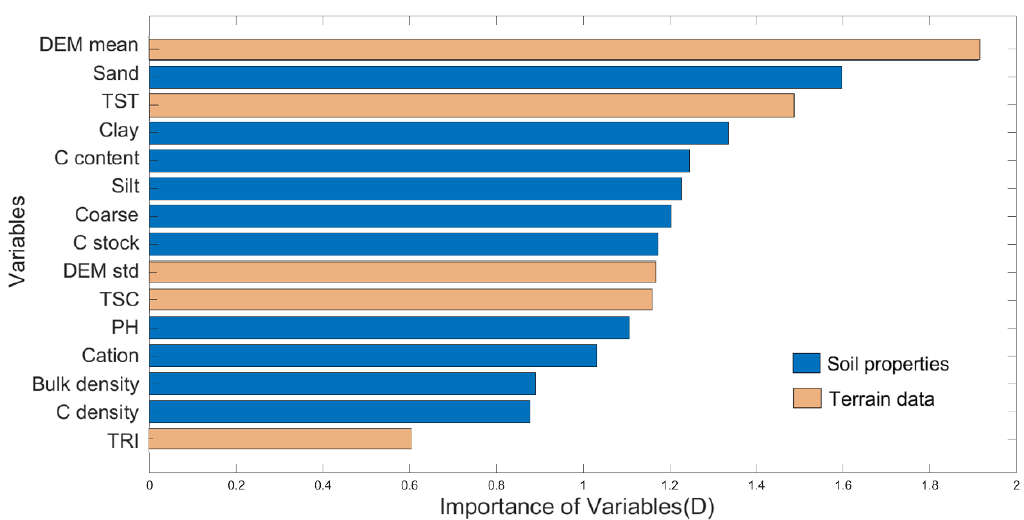
Figure 5. The computation results of the 𝐷 values in 2018. ( a ) Map of the retrieved 𝐷 soil parameter; ( b ) map of the RF predicted 𝐷 soil parameter; ( c ) histogram of the retrieved 𝐷 , and ( d ) scatterplot between the retrieved and RF predicted values for the 𝐷 values.